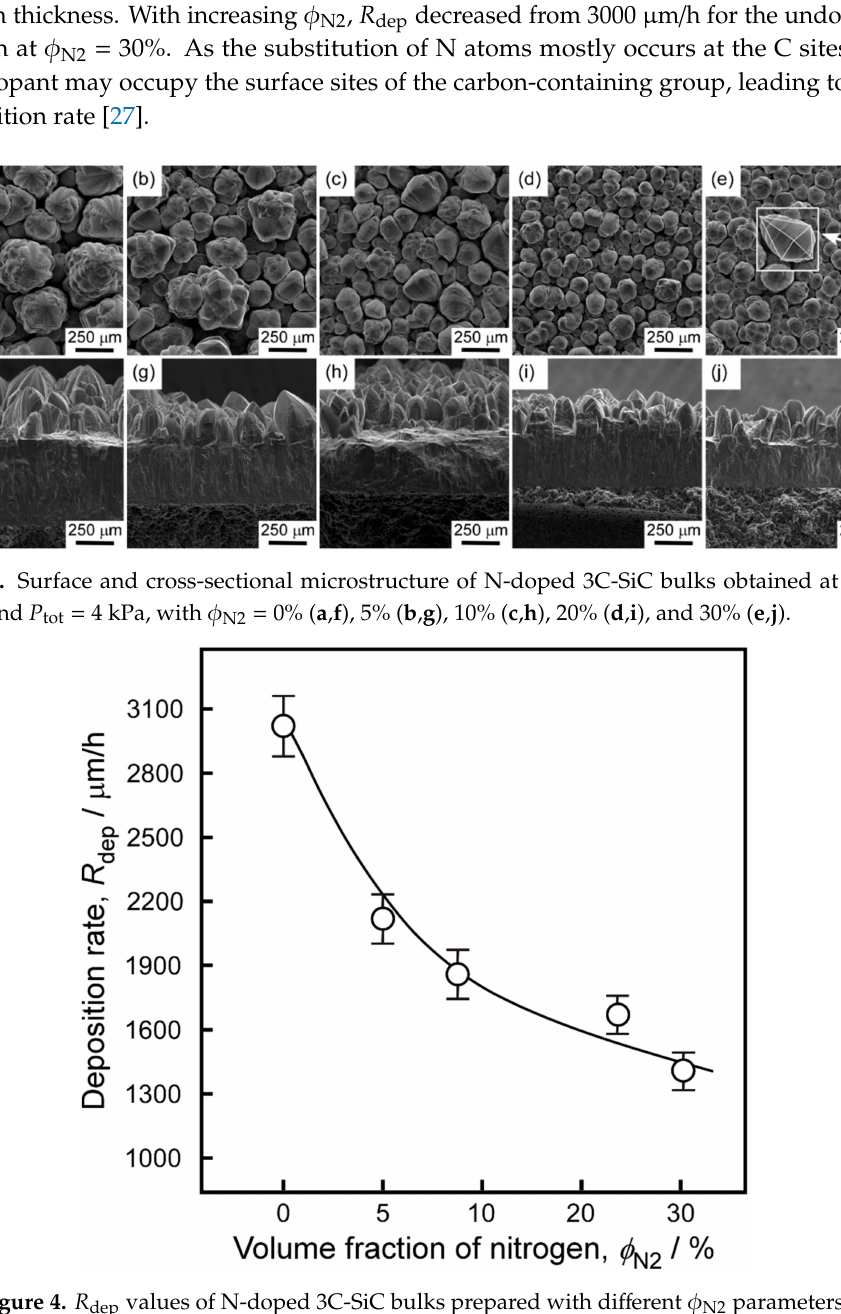
Figure 4. R dep values of N-doped 3C-SiC bulks prepared with di ff erent φ N2